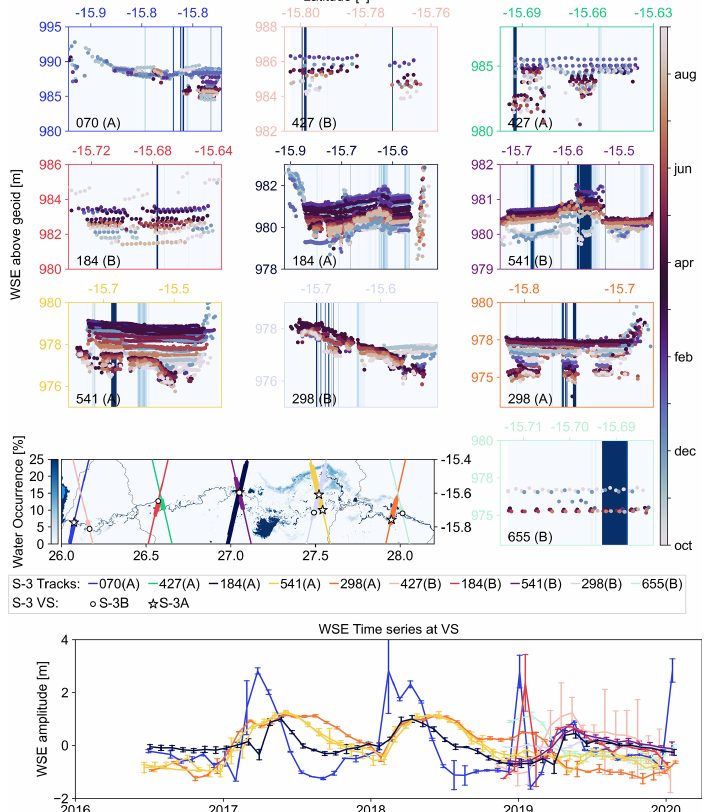
Figure 14. Floodplain dynamics in the Kafue Flats as observed by Sentinel-3A and Sentinel-3B. The tracks are ordered by longitude moving left to right on the map. The water surface elevation (WSE) cross sections are in order of crossing tracks from west to east. The line colors in the time series correspond to the track colors from the map and the width of the line indicates the observations shown in the scatter plots. The frame colors and line colors in the time series correspond to the track colors from the map. The error bars reflect the standard deviation for each pass used in the time series. The water occurrence thresholds are deliberately set from to 0%–10% to enable the visualization of the